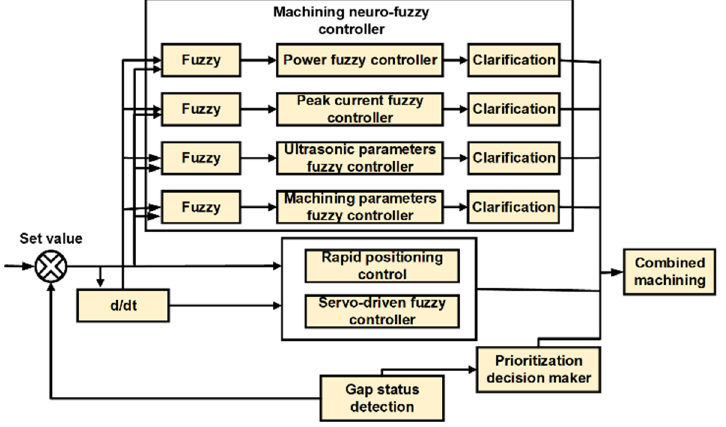
Figure 5. Machining controller structure block diagram.